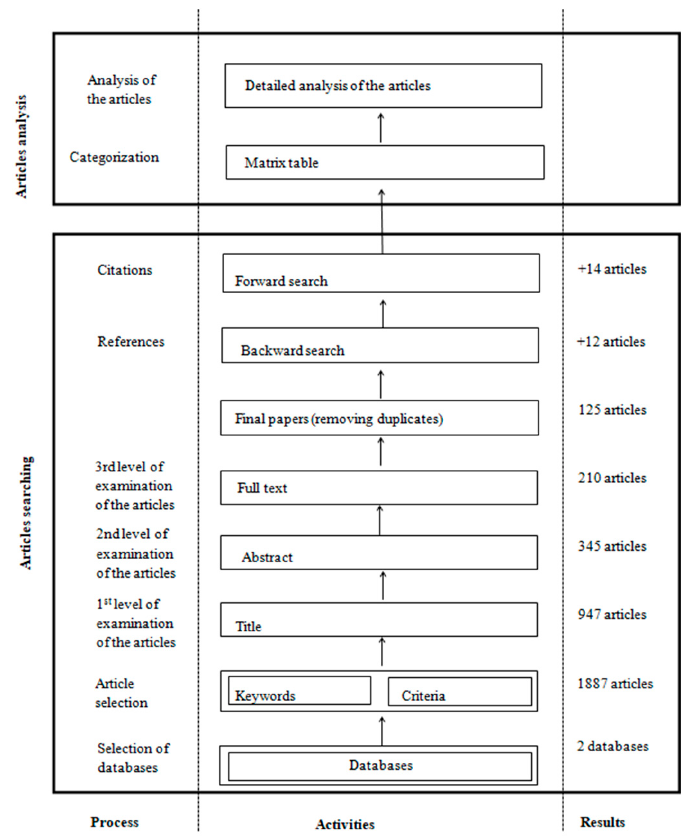
Figure 1. Article selection process.